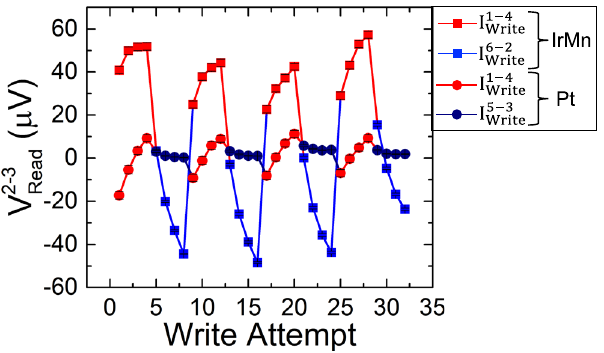
Fig. 3 Measured differential voltage ( V 2-3 Read ) for the 90° switching con fi guration with 20 mA write pulses. Square data points indicate the case where the write current pulses are applied in the cross containing the IrMn 3 pillar ( I 1-4 write , red squares, and I 6-2 write , blue squares), and circle data points correspond to the case when the pulse is applied to the other cross ( I 1-4 write , red circles, and I 5-3 write , dark blue circles). Note that one of the writing currents in the latter case ( I 1-4 write ) also passes through the cross with the IrMn 3 pillar. The differential voltage, V 2-3 Read , only shows switching in the cases where the current pulse passes through the cross containing the IrMn 3 pillar, i.e., all cases except I 5-3 write . Each data point corresponds to the mean value of 170 consecutive measurements and the error bar to the standard deviation. Raw data for this fi gure (prior to subtraction of the background slope) can be found in Supplementary Note 3.